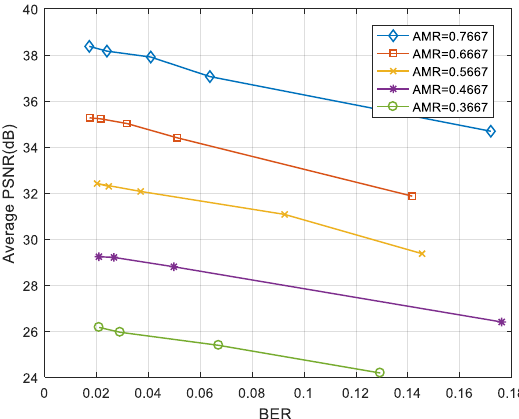
Figure 13. BER-PSNR performances for the “ foreman ”.